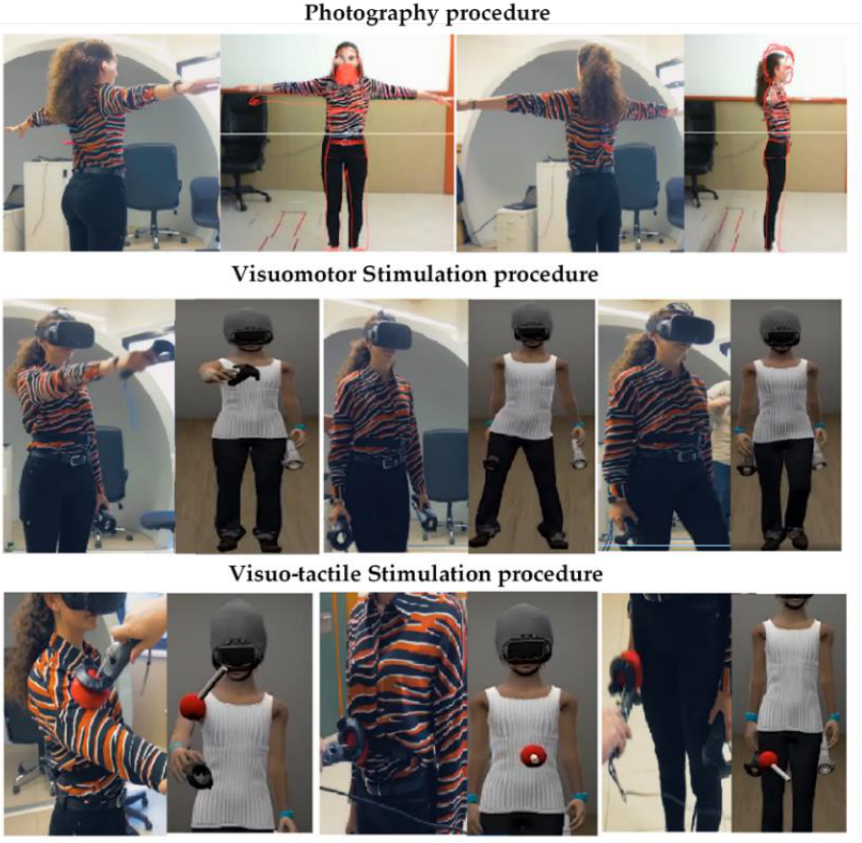
Figure 2. Visuomotor and visuo-tactile stimulations conducted in the pre-assessment and post- assessment sessions and in each treatment session.